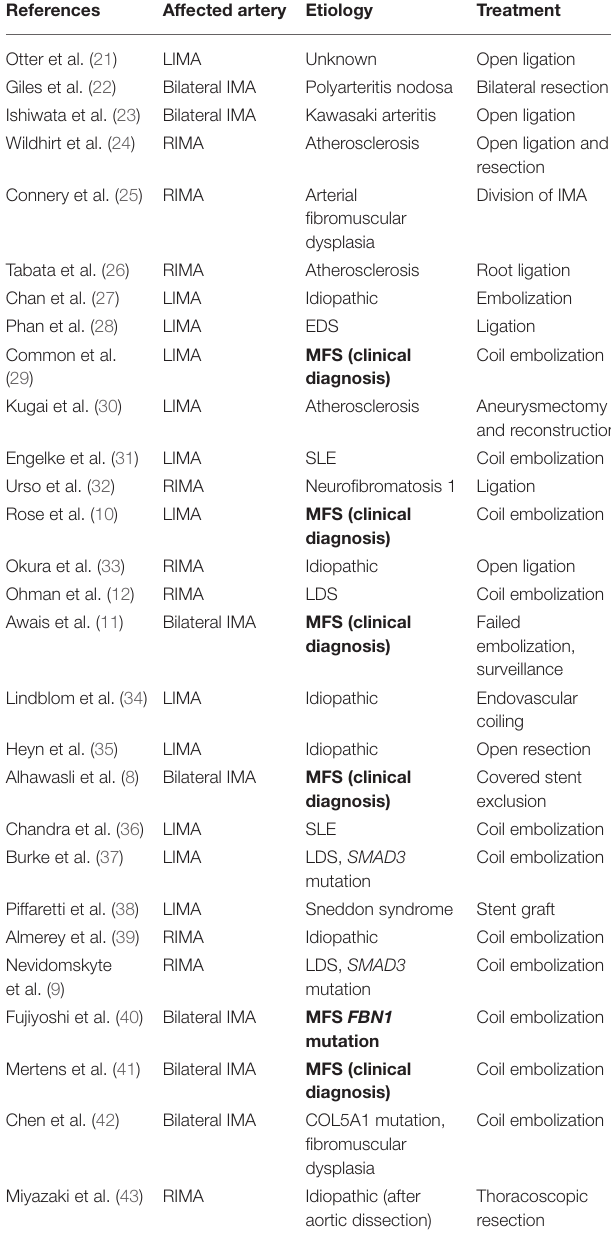
TABLE 1 | Published true aneurysms of internal mammary